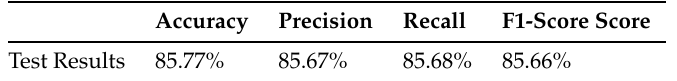
Table 16. Evaluation results of the model trained by LSTM network using raw measurements.